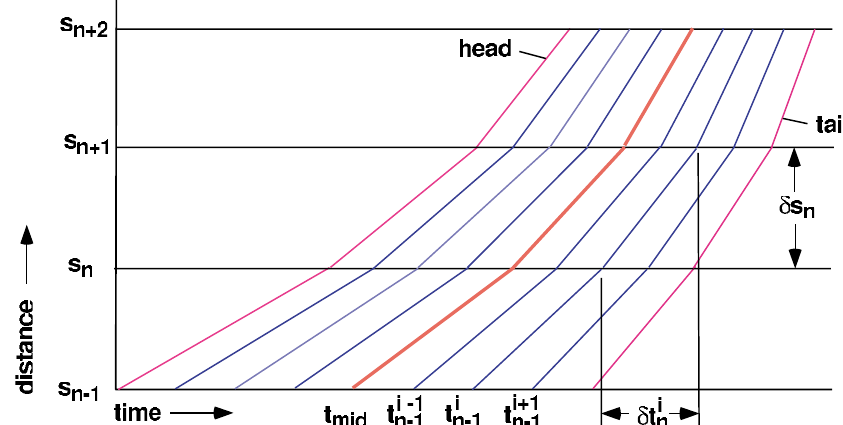
FIG. 1 (Color) Cartoon illustrating the basic algorithm for setting induction-cell voltages. Each beam slice has a ballistic trajectory between cell locations s n , and for self-similar compression, the relative spacing of slices is kept constant at each cell. Cell voltages are then calculated as functions of time from the slope change of beam-slice trajectories.